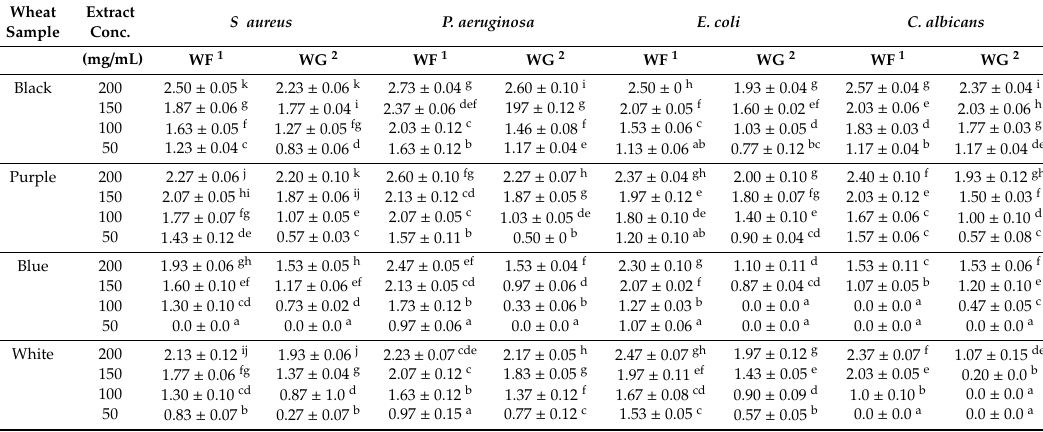
1—WF (wheat flour); 2—WG (wheat-grass juice). Values are the means of three replicates ± standard deviation. Values followed by same letter in column are not significantly di ff erent (Tukey’s test, p >